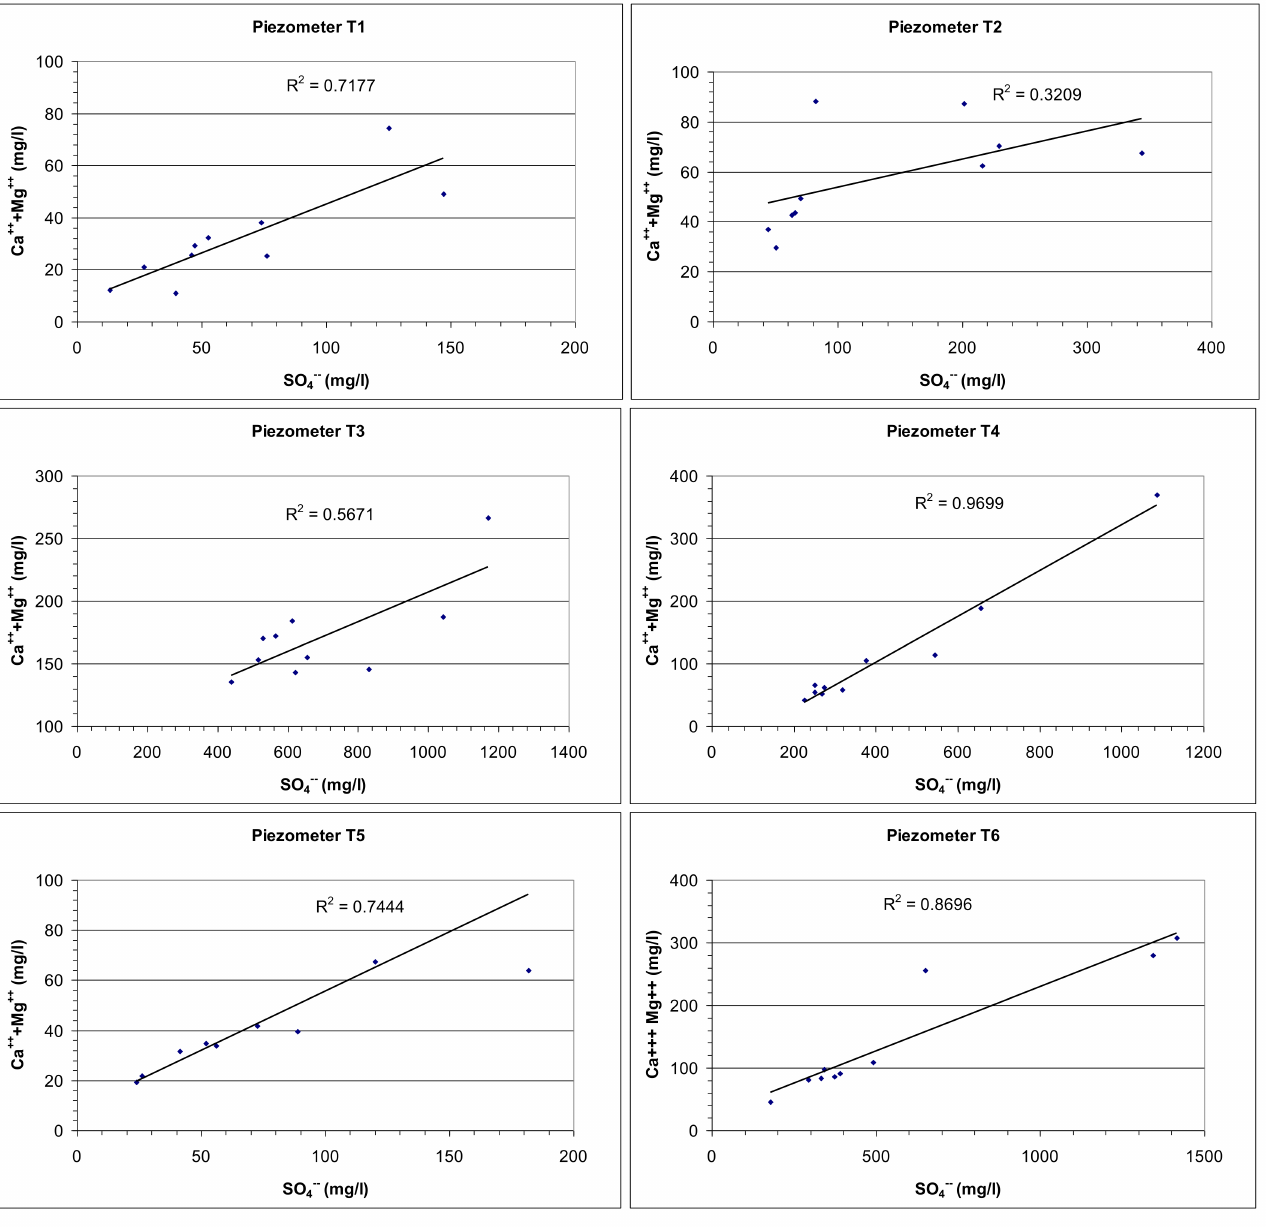
Figure 6. Evolution of Ca 2+ + Mg 2+ vs. SO4 2 −